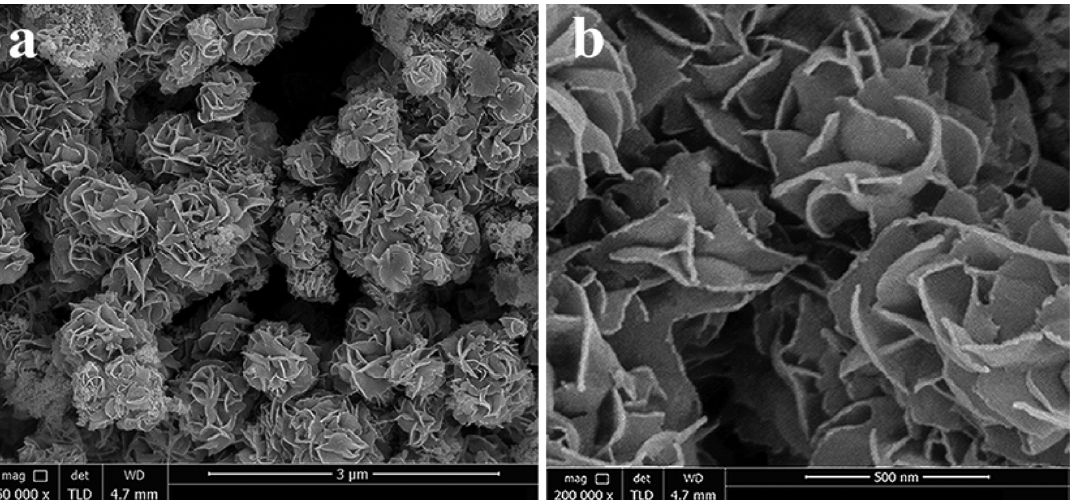
Figure 5. ( a , b ) SEM images of MoS 2 @TiO 2 composites. Reprinted with permission from Ref. [77]. Copyright 2016 American Chemical Society.